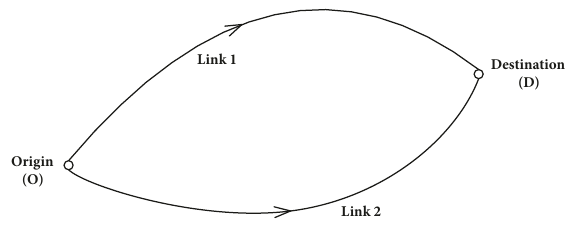
Figure 1: Two-link road network considered in the study.